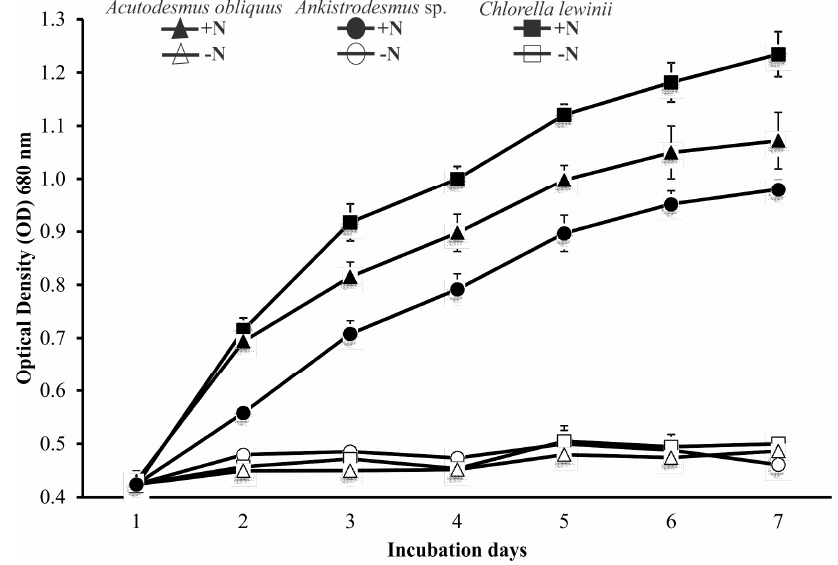
Figure 2. Growth profiles of three microalgal strains cultivated under +N (filled boxes) and − N (empty boxes) Chu medium No. 10. The culture was incubated in a controlled culture room at 25 ± 1 °C with 12:12-h light-dark cycles using 80 µE·m − 2 ·s − 1 intensity of cool-white fluorescent light and continuous agitation at 150 rpm. Experiments were carried out in triplicate.